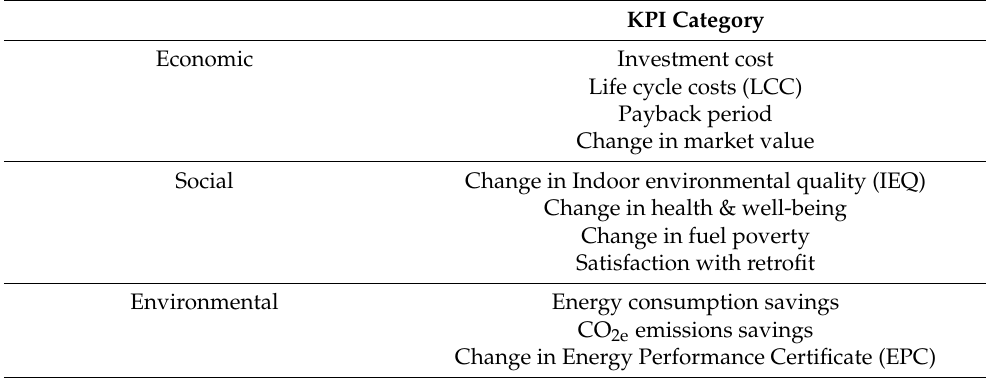
Table 2. Recommended key performance indicators (KPIs) of energy efficient retrofits to existing residential